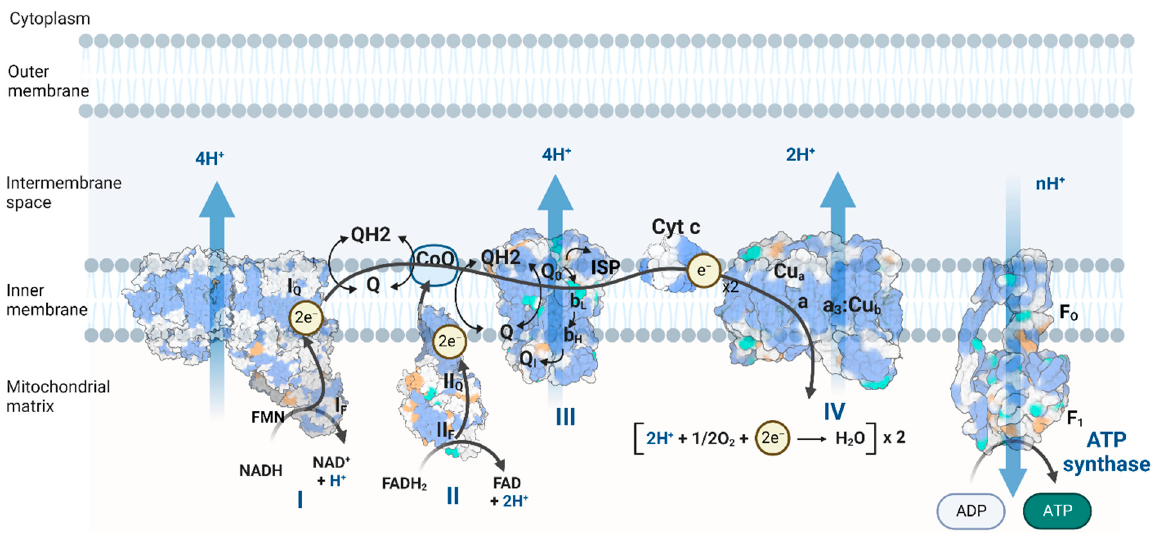
Figure 1. Schematic of OXPHOS, including the electron transport chain (ETC) and ATP synthase. The figure was adapted and created from “Electron Transport Chain”, by BioRender.com (accessed on 20 August 2022). Retrieved from https://app.biorender.com/biorender-templates (accessed on 20 August 2022).